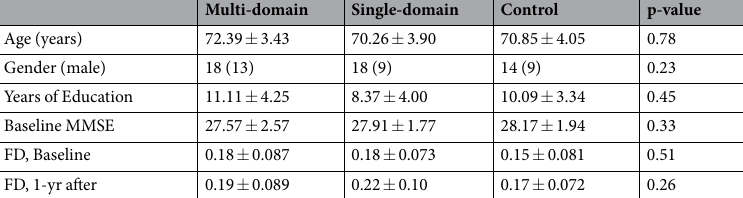
Table 1. Demographic information of the older adult participants at